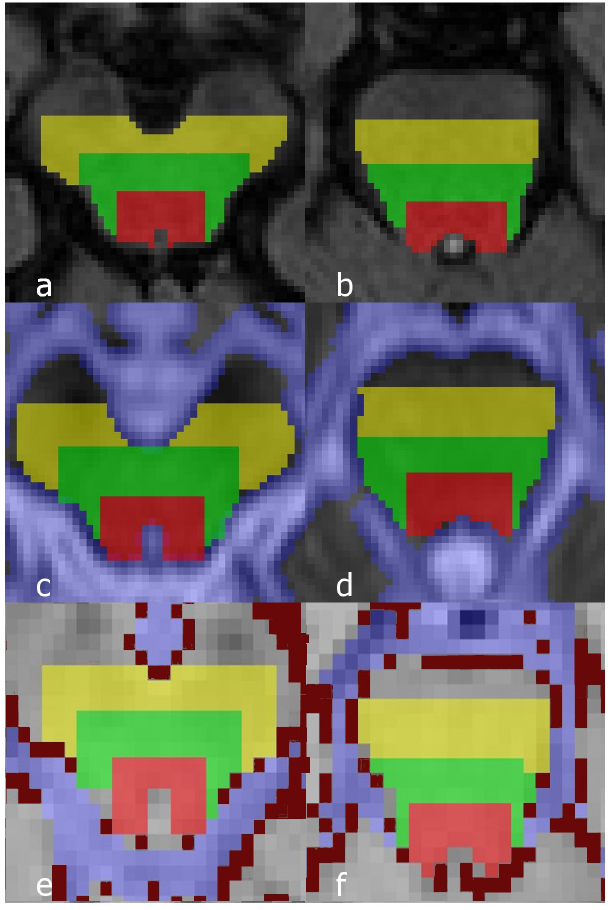
Fig 2. Example images after application of ROIs. FLAIR images at the level of the mesencephalon (a) and pons (b) after application of ROIs (red = posterior ROI, green = middle ROI, yellow = anterior ROI). Corresponding ADC (c, d) and time averaged perfusion raw data (e, f) after alignment and masking of the ROIs. Pale blue voxels (c-f) represent the CSF mask in both the ADC map and perfusion data and dark red voxels (e, f) represent the vessel mask in the perfusion data. Due to corrections for spatial differences and masking, the final ROI in the ADC and perfusion data differ slightly in shape compared to the original ROIs drawn on FLAIR images. Only one of two slices for each location is